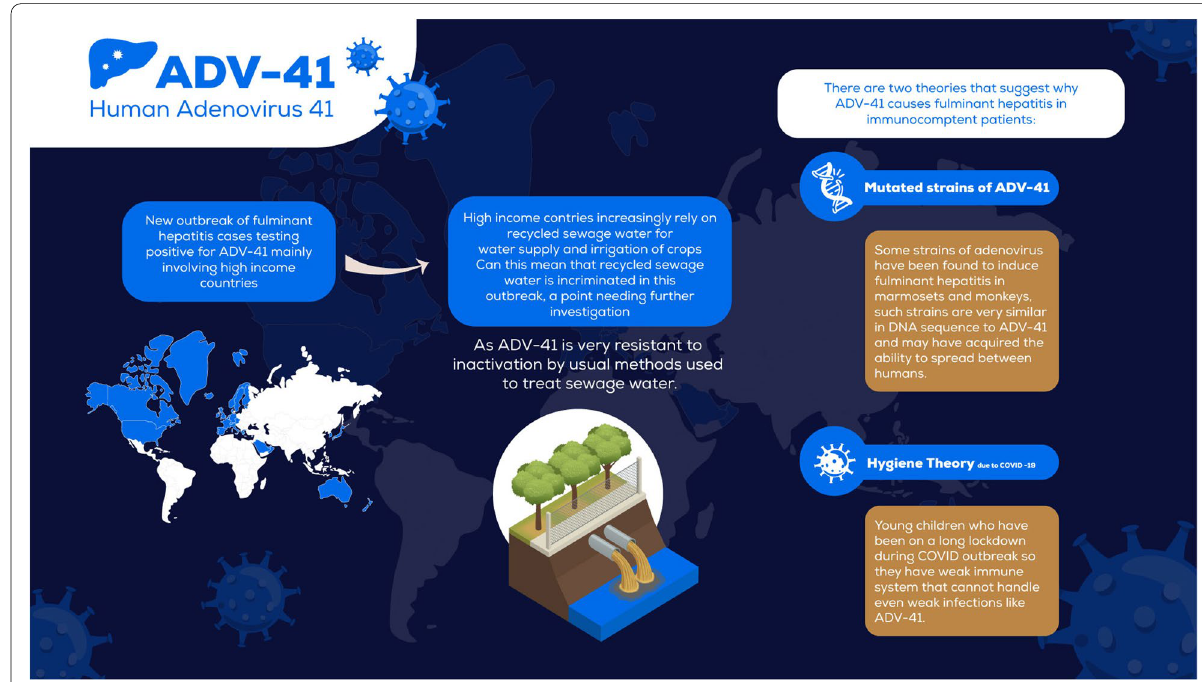
Fig. 1 Can be sewage water recycling be implicated in the unknown hepatitis outbreak. Abbreviations: ADV41, adenovirus 41; COVID‑19, coronavirus disease